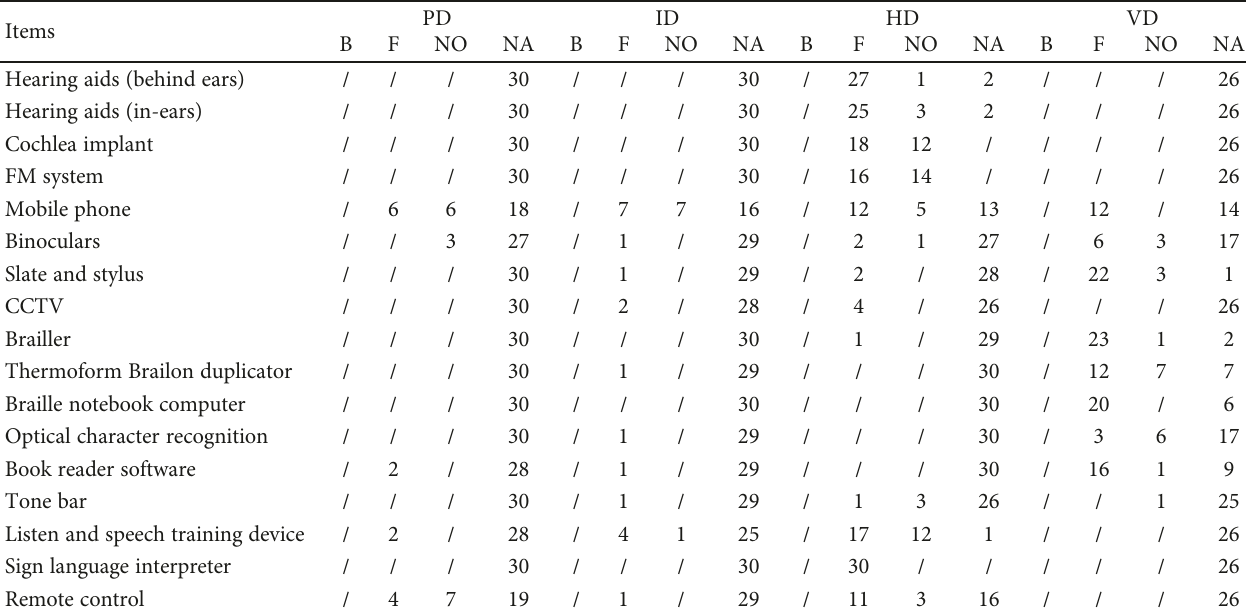
Table 4: Facilitators and barriers of AT for